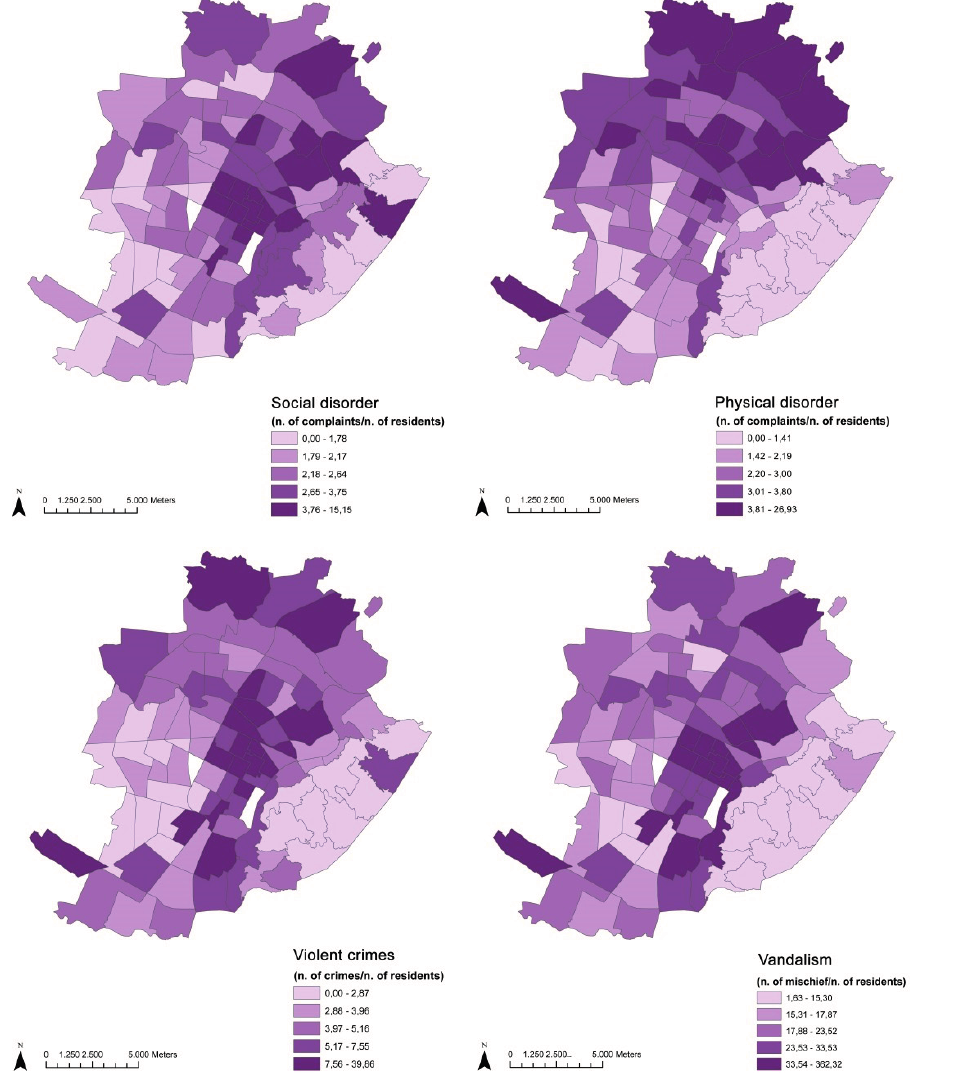
Figure 4. Distribution of SE